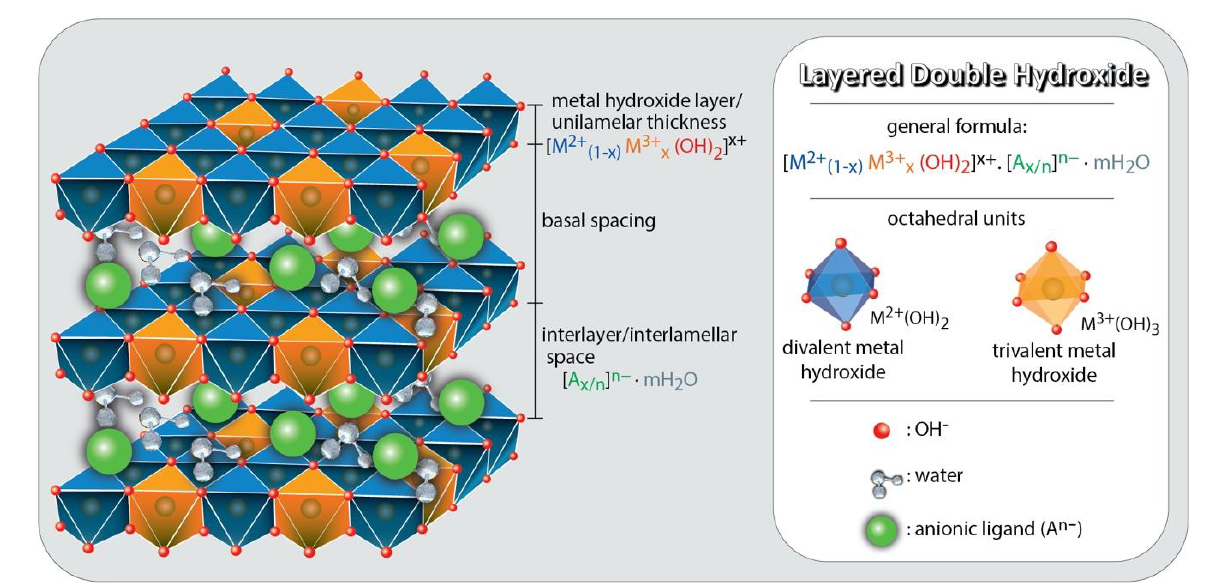
Figure 2. A schematic presentation of the layered double hydroxides (LDHs) chemical composition and structure. Figure reproduced from reference [30]. Copyrights Elsevier, 2022.